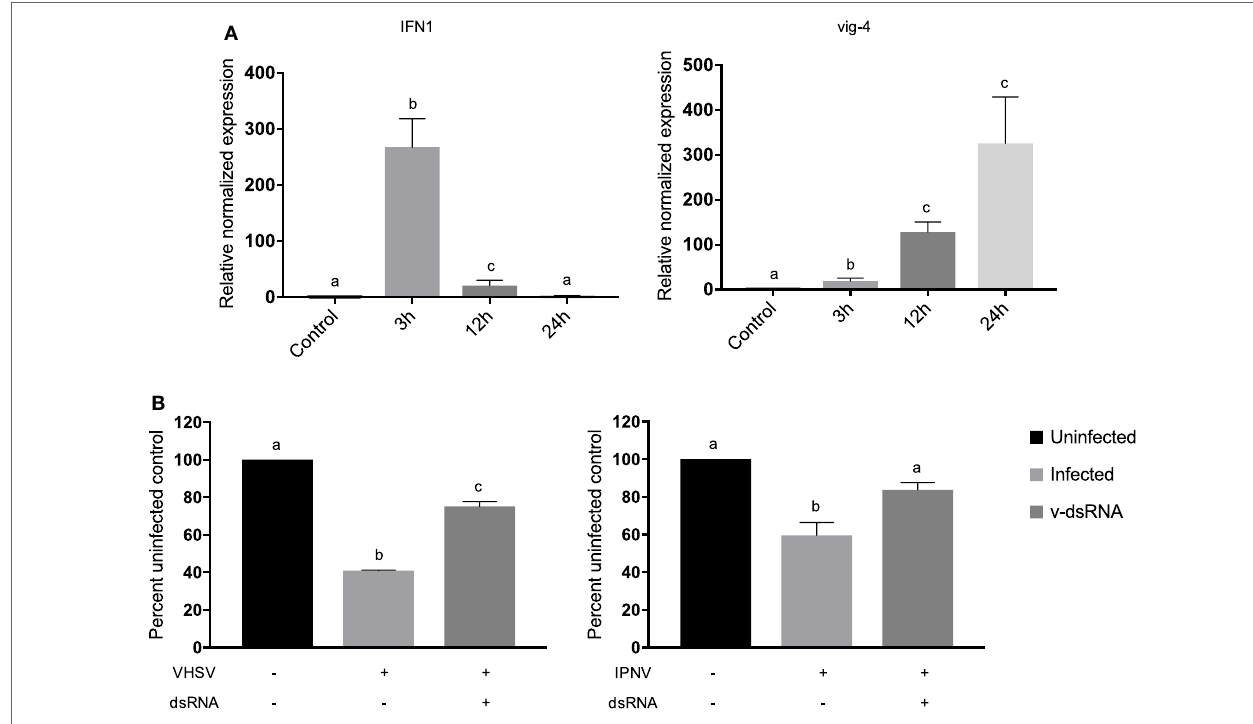
FigUre 2 | Viral dsRNA induces IFN1 and vig-4 transcripts over time and induces a protective antiviral state against viral hemorrhagic septicemia virus (VHSV) and infectious pancreatic necrosis virus (IPNV) in RTG-2 cells. (a) RTG-2 cells were stimulated with 10 ng/mL of total chum salmon reovirus dsRNA (v-dsRNA); IFN1 and vig-4 transcripts were measured by qRT-PCR at 3, 12, and 24 h, normalized to β -actin, and presented as values relative to an unstimulated control. (b) RTG-2 cells were pretreated with 10 ng/mL v-dsRNA for 3 h and then infected with VHSV at a multiplicity of infection (MOI) of 10 or IPNV at an MOI of 0.2. After 4–7 days, a fluorescent indicator dye, alamarBlue, was used to measure cell viability, and data are presented as the percentage of an untreated, uninfected control. Data represent three independent replicates and were analyzed statistically by one-way ANOVA, alpha = 0.05; a P value < 0.05 considered